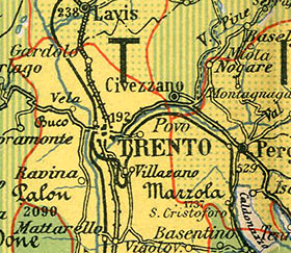
Figure 1. Hatching example from the 1915 Battist’s